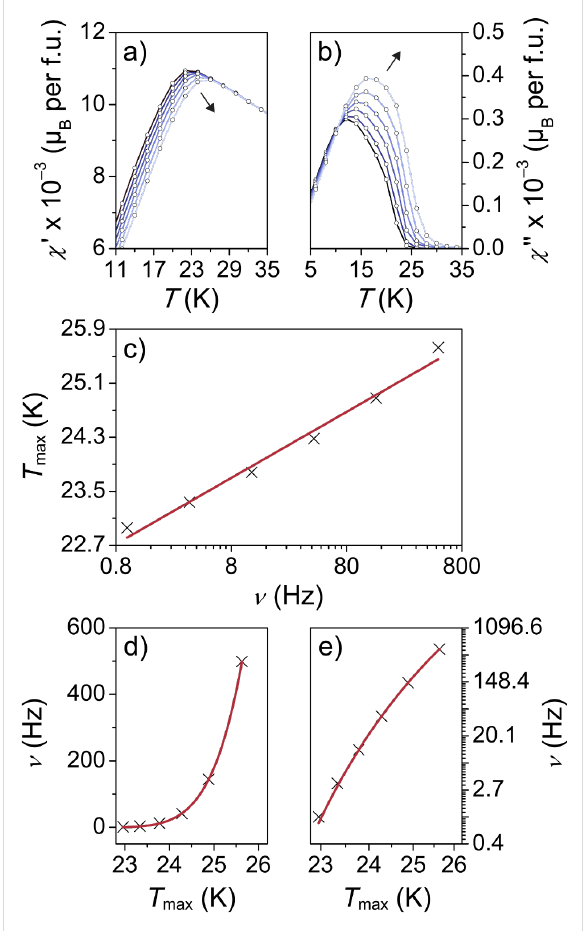
Figure 6: Alternating-current SQUID magnetometry of as-prepared ZFO nanoparticles with µ 0 H AC = 0.35 mT. (a) In-phase and (b) out-of- phase parts of the magnetic susceptibility. (c–e) Frequency depen- dence of the peak temperature in the χ ’( T ) curve. The red lines are fits to the data according to p = Δ T max /[ T max × Δ log( ν )] in (c), ν = ν 0 × [( T max – T 0 )/ T 0 ] z υ in (d) and ν = ν 0 × exp[ –E a / k B ( T max – T 0 )] in